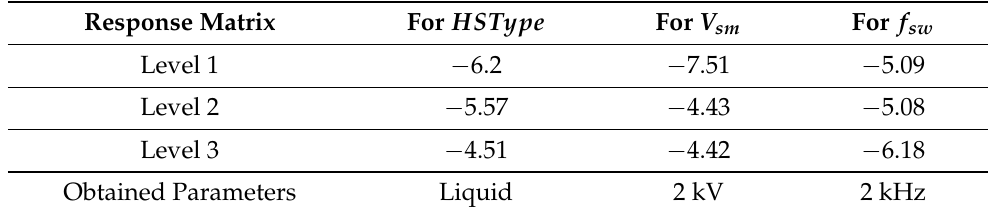
Table 3. Response matrix for MMC for Table 2.